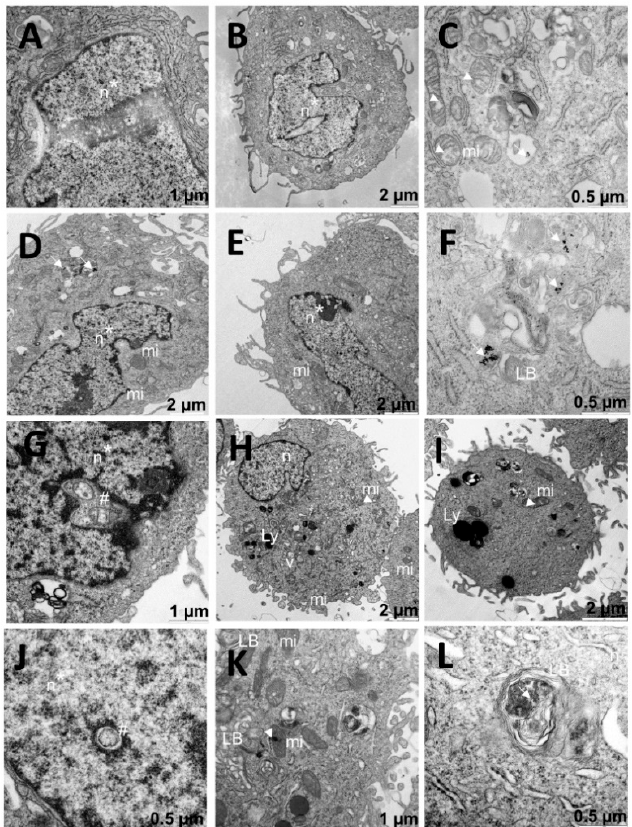
Figure 8. TEM images of A549 cells treated with C 1 ( A – C ), C 2 ( D – G ), and C 3 ( H – L ). Arrows indicate dense bodies compatible with the gold cores ( D , F ). Arrowheads indicate possible damage to mitochondria with small vacuoles or dense internal clusters ( C , I , K ). Asterisks indicate damaged nuclei, and hashmarks indicate structures invading nuclei ( A , B , D , E , G , I ). Abbreviations: LBs: lamellar bodies; Ly: lysosome; mi: mitochondria; n: nucleus; v: vesicle.